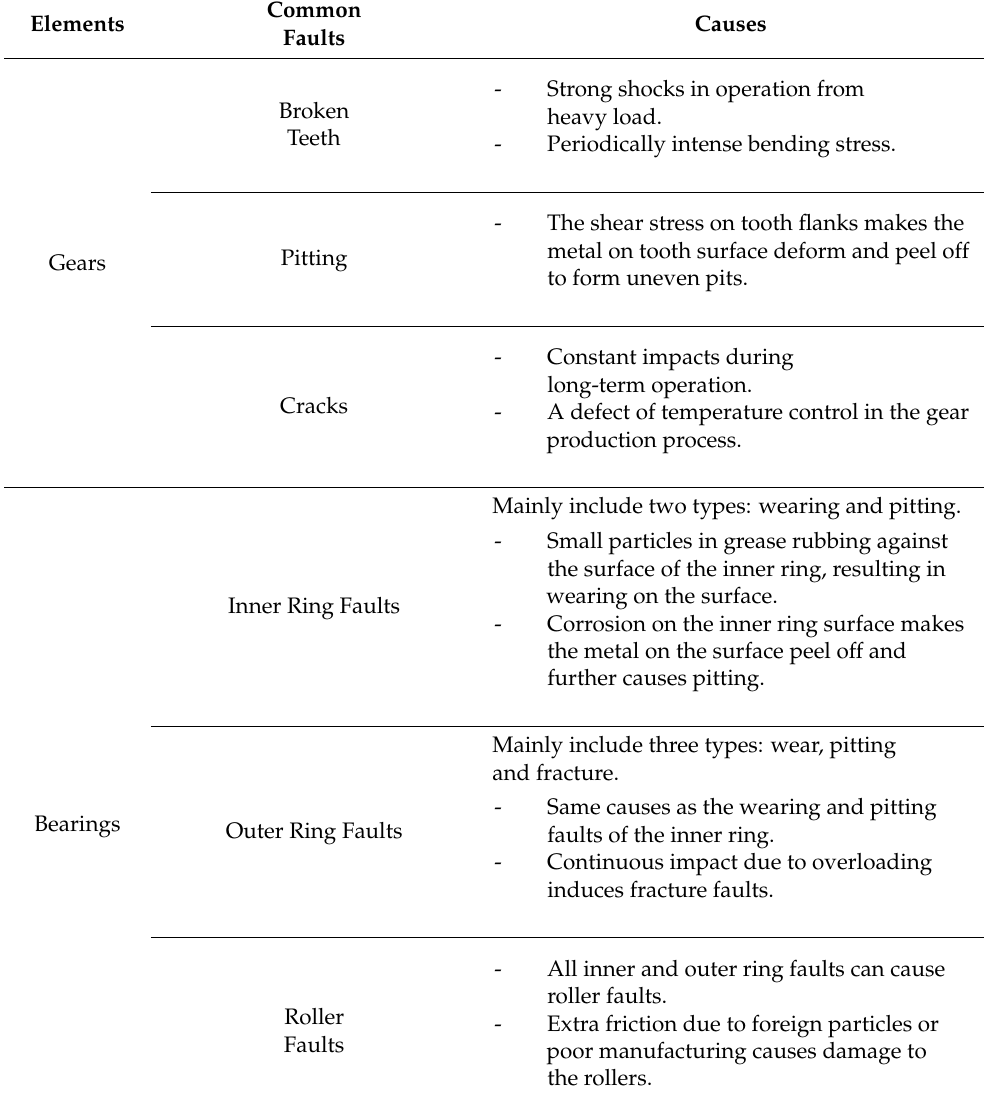
Table 1. Common faults of gears and bearings